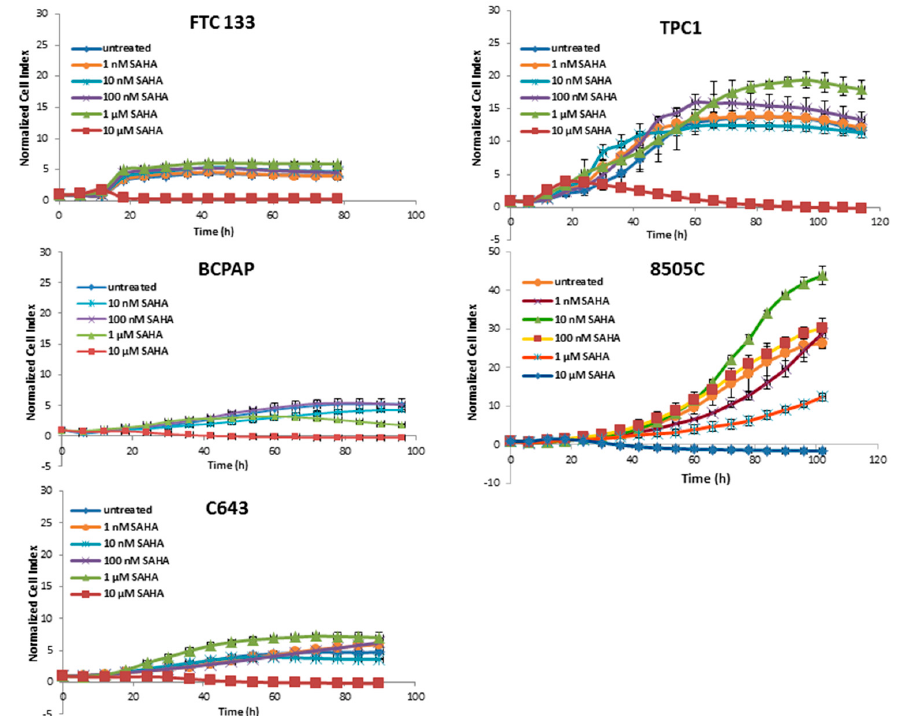
Figure 2. Real time cell viability of thyroid cancer cells treated with SAHA. FTC133, TPC1, BCPAP, 8505C, and C643 cells were plated on gold-coated 96-well plates. After approx. 24 h, SAHA was added at concentration between 1 nM and 10 µM. The cell viability was monitored constantly for up to 100 h. Cell index was normalized to the time point of treatment. Shown are means ± SD of three independent experiments performed in triplicates.